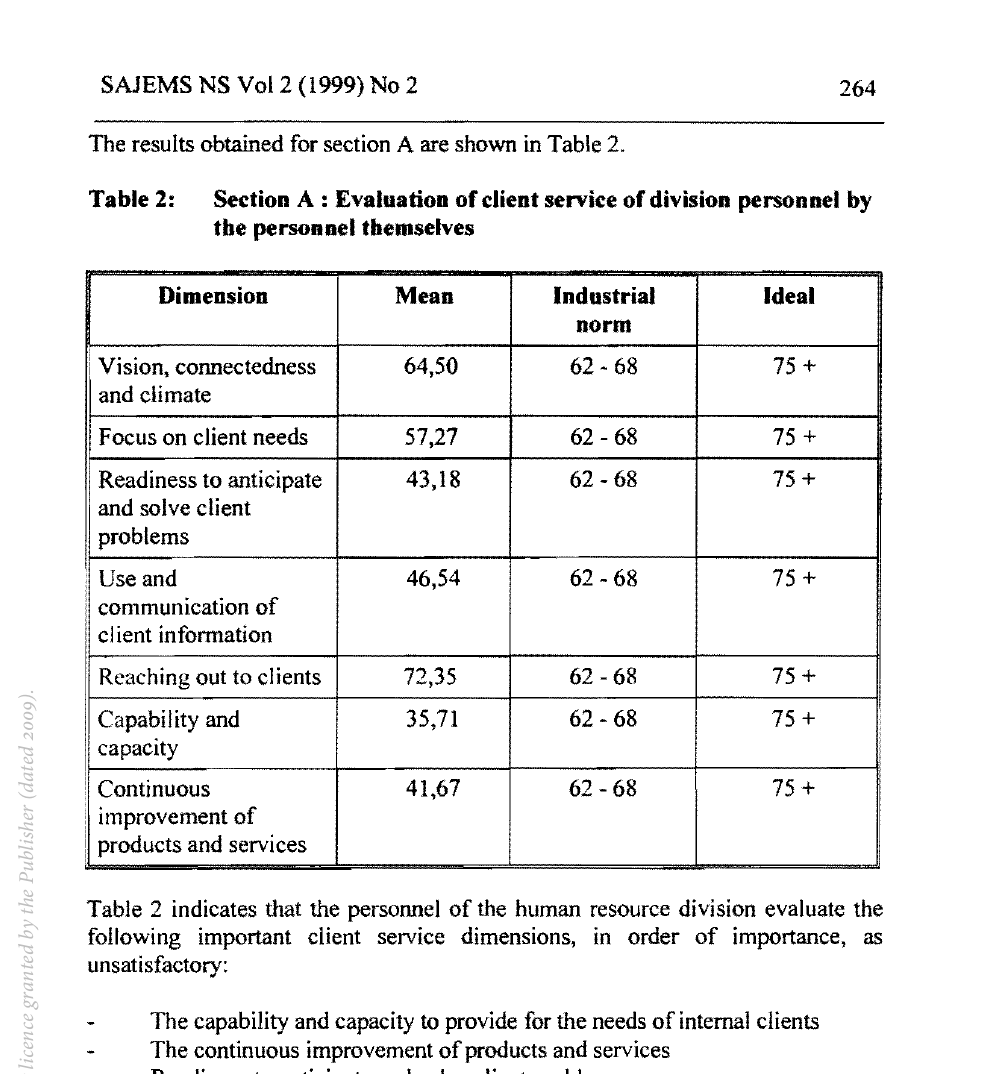
Section A : Evaluation of client service of division personnel by tbe personnel